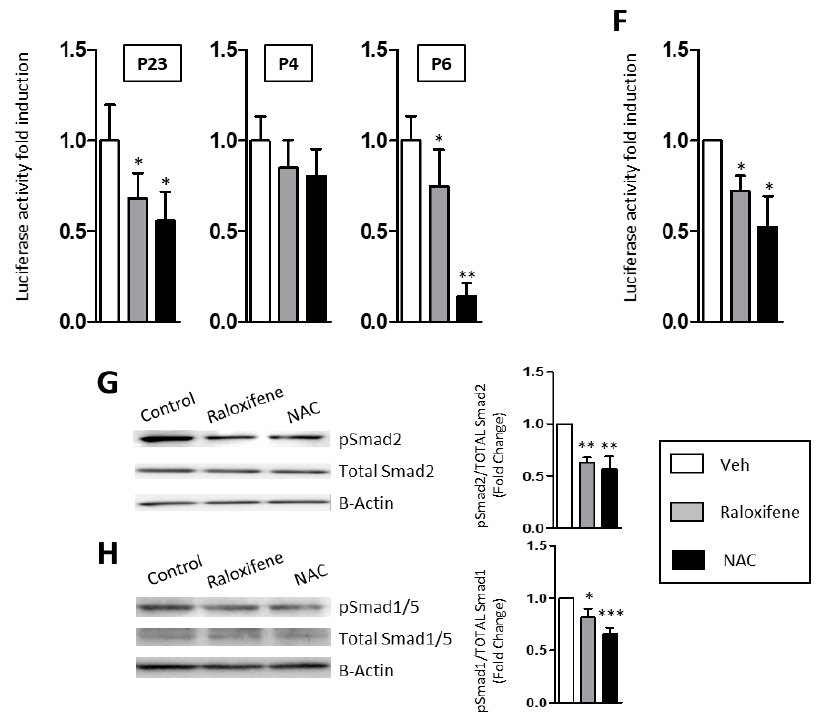
Figure 3. Raloxifene modulates TGF- β 1 signaling. Human fibroblasts from RDEB patients were transiently transfected with the CAGA-luc ( A , B ) and BRE-luc ( D , E ) reporter vectors in which the SBE (Smad Binding Elements) sequences in the promoter of the reporters is underlined. Luciferase assays were performed on the fibroblasts from the three patients. Panels ( B , E ) show the mean induction in the three patients individually, while ( C , F ) is the average of the three patients altogether. Luciferase activity was measured in untreated cells or cells exposed to raloxifene or NAC for 48 h, in the presence of TGF- β 1 during ( B ) the last 24 h, or ( E ) 3 h. ( G , H ), Western blot analysis of p-Smad2 ( G ) and p-Smad1 / 5 ( H ) protein in cells treated with raloxifene, NAC or the vehicle alone during 48 h in the presence of TGF- β 1 during ( G ) the last 24 h or ( H ) 3 h. Total Smad2 or Smad1 / 5 were used as controls and β -Actin was used to confirm similar loading between the samples. Representative Western blots are shown and the quantification (mean ± SEM) of the three patients are shown. Di ff erences were statistically significant according to the Student’s t -test: * p < 0.05; ** p < 0.01; *** p <